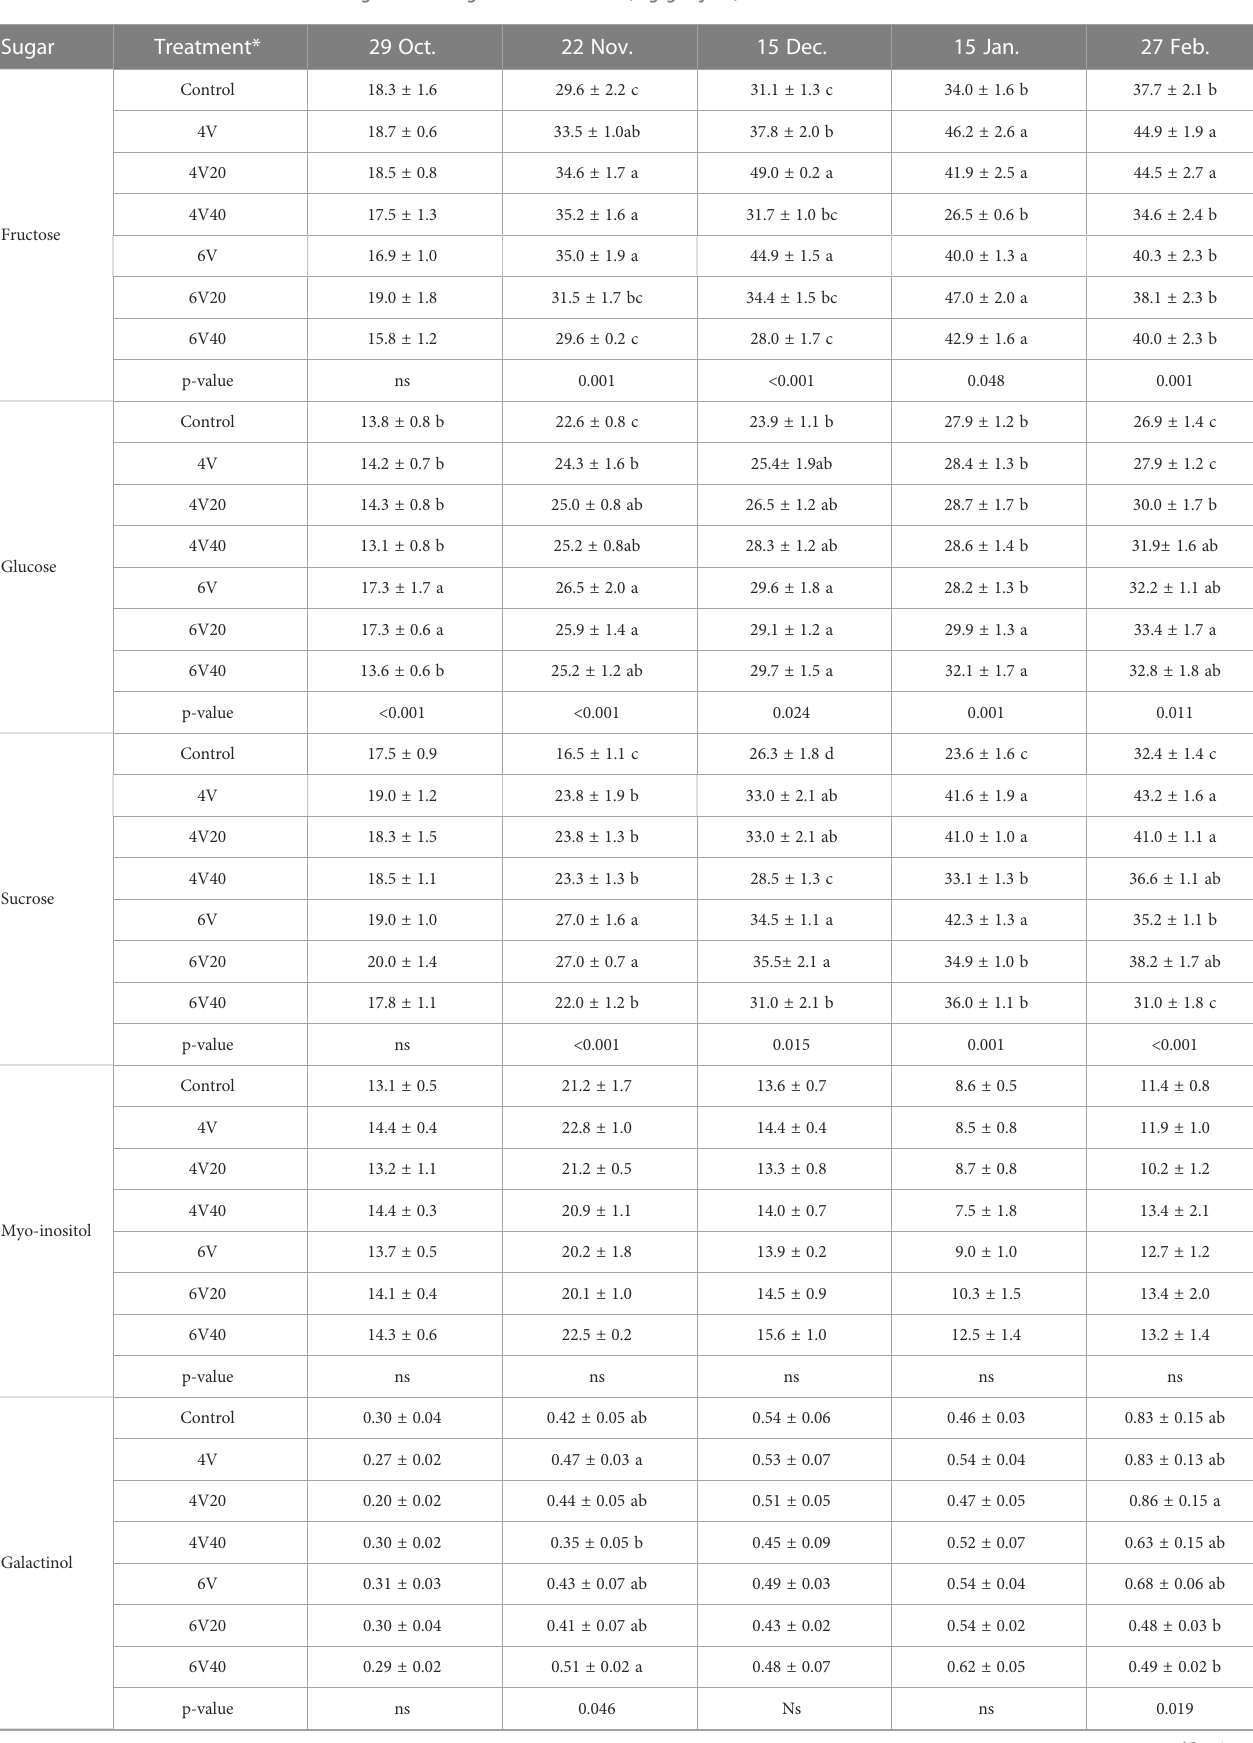
TABLE 1 Effect of ABA on the seasonal changes of the sugar concentrations (mg/g dry wt) in ‘ Chambourcin ’ buds. Sugar Treatment* 29 Oct. 22 Nov.